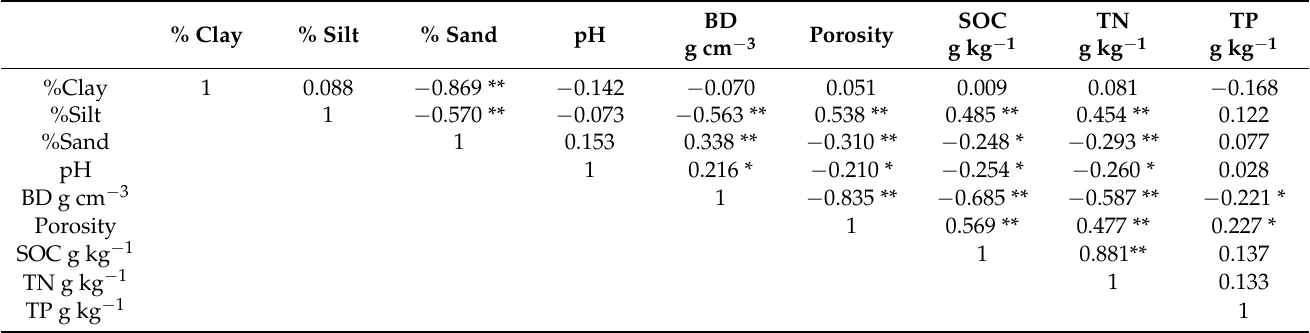
Table 1. Pearson correlation matrix between soil texture, pH, BD, porosity, SOC, TN, and TP in Kilombero